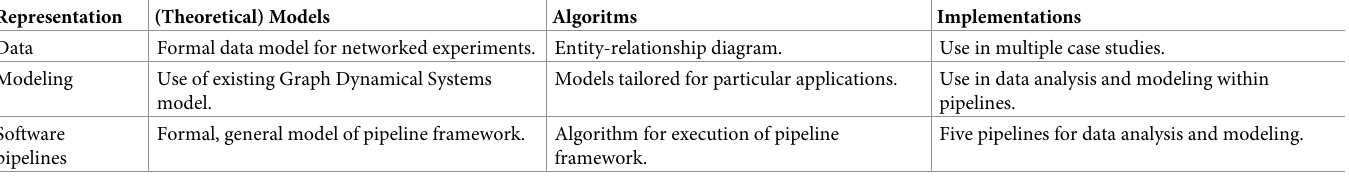
Table 2. This work involves three major topics (left column of table): Data representation, modeling representation, and software pipelines. Representation (Theoretical) Models Algoritms Implementations Data Formal data model for networked experiments. Entity-relationship diagram. Use in multiple case studies. Modeling Use of existing Graph Dynamical Systems Models tailored for particular applications. model. Software Formal, general model of pipeline framework. Algorithm for execution of pipeline pipelines